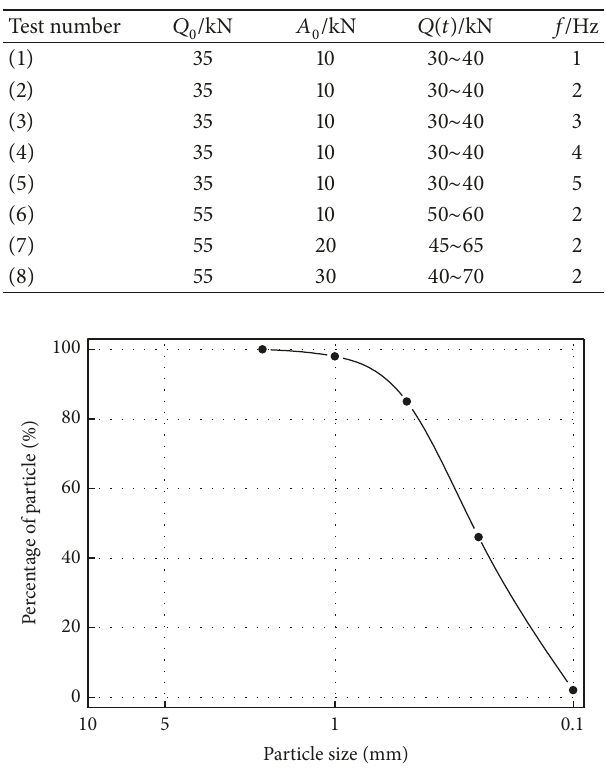
Table 4: Vibration tests information.